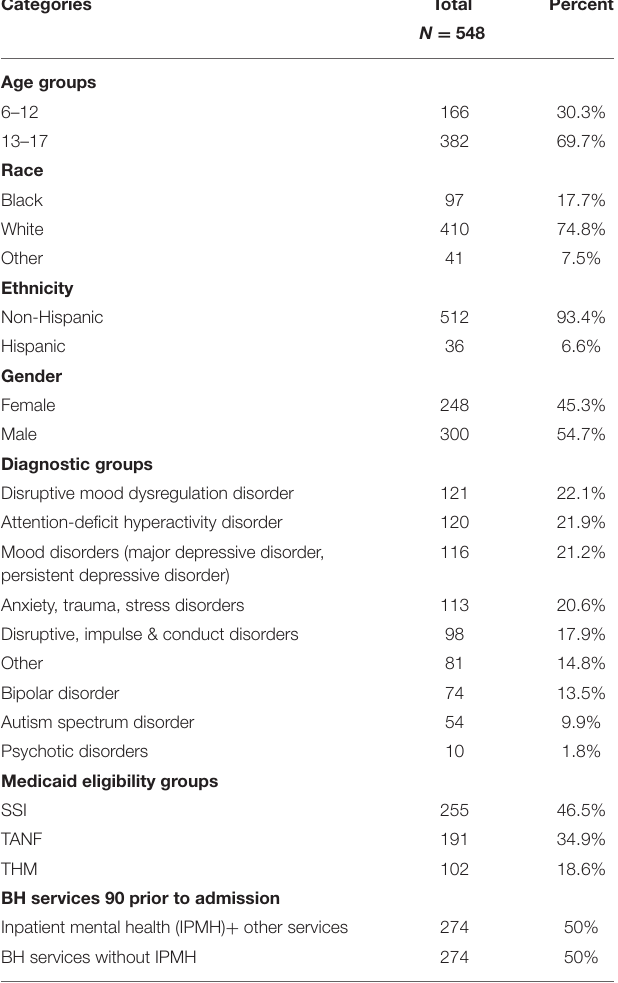
TABLE 1 | Demographic and clinical characteristics of youth at time of admission to PRTF.